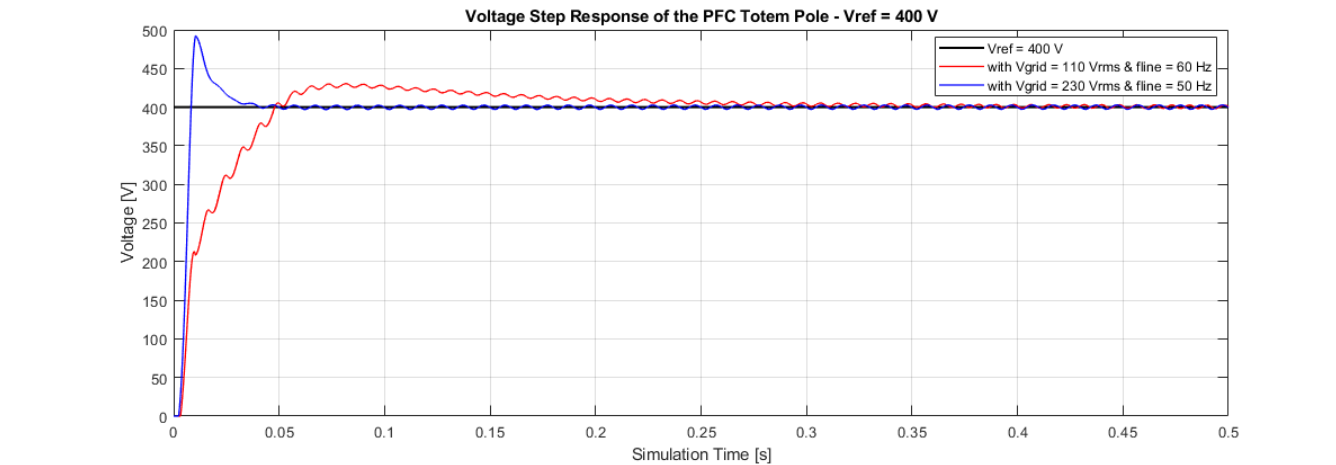
Figure 13. Voltage control of the Totem Pole with V ref = 400 V.